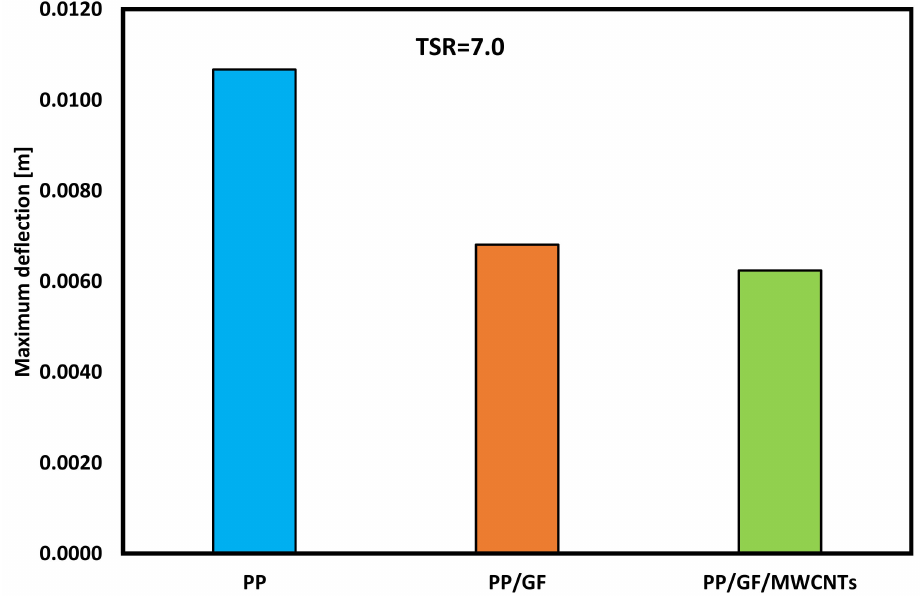
Figure 13. Maximum deflection of blades with various materials at TSR =